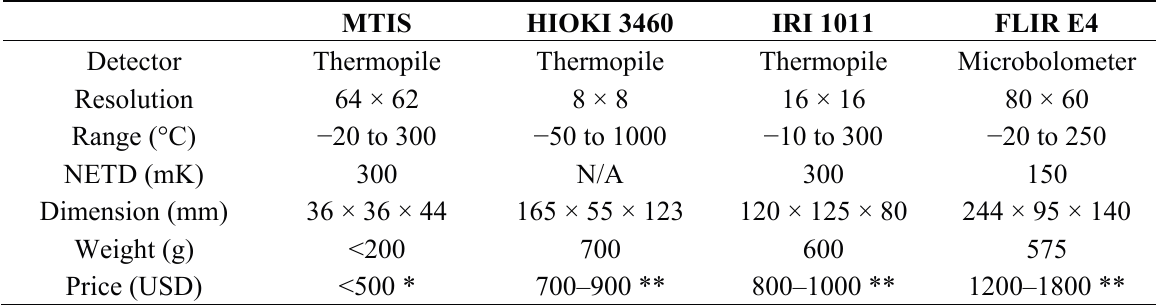
Table 3. Comparison among four low-cost thermal imagers.